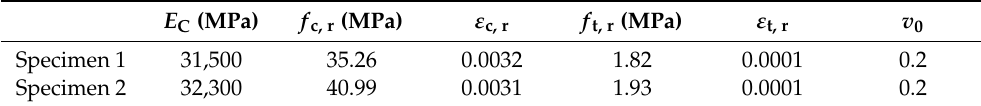
Table 1. Basic parameters of concrete damage plastic Figure 4. Grid division of reinforced concrete slab.